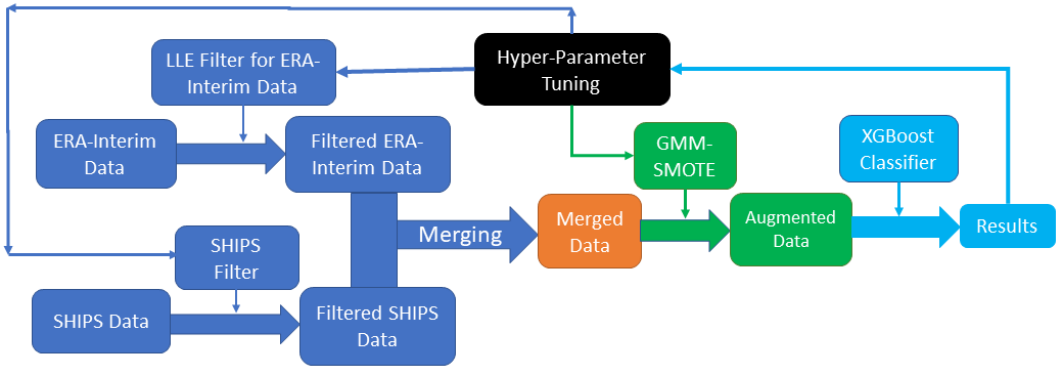
Figure 1. The LLE ‐ SHIPS model structure. Figure 1. The LLE-SHIPS model